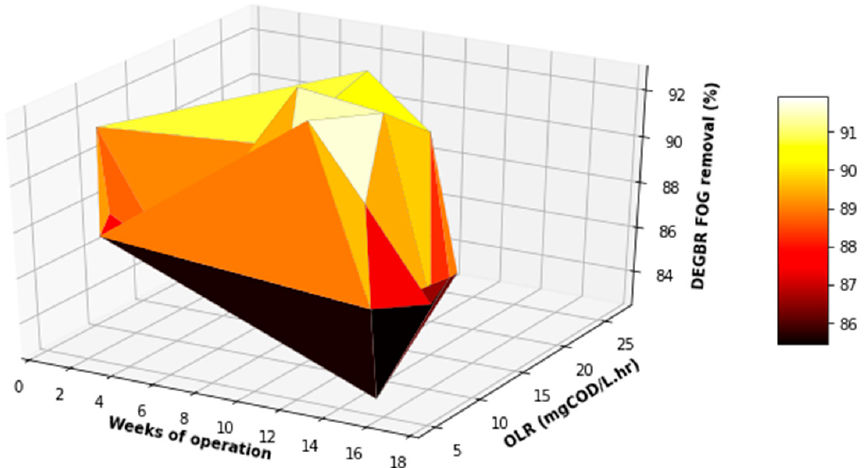
Figure 11. Performance of the DEGBR with respect to FOG removal under varying OLRs.